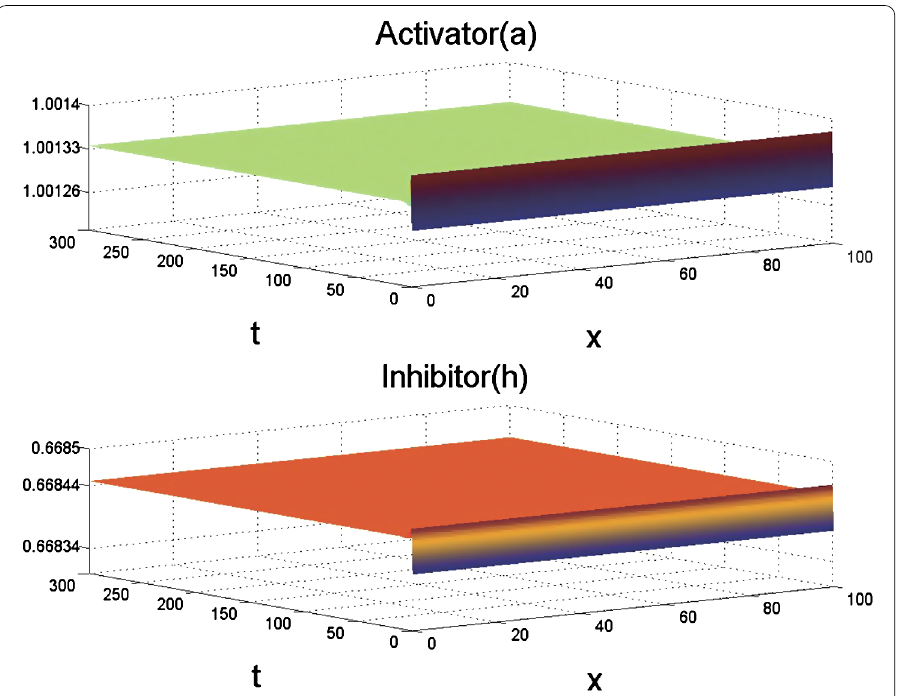
Figure 8 The persistence of the stable equilibrium under conditions (H2) and (H5)